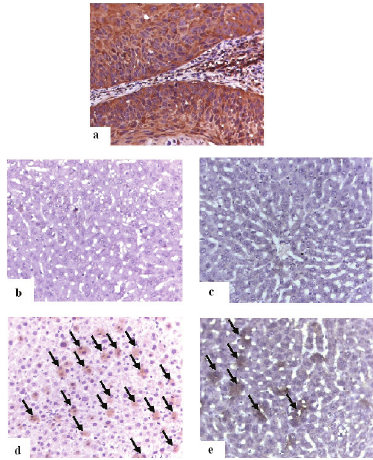
Figure 2 - Immunohistochemical expression of NFkB. (A) Positive NF κ B staining in cervical cancer tissue at optimum concentration of 1:500, (B) Control group (C) Ginger extract group, (D) Choline deficient diet with ethionine in drinking water, CDE group and (E) CDE + ginger extract (100